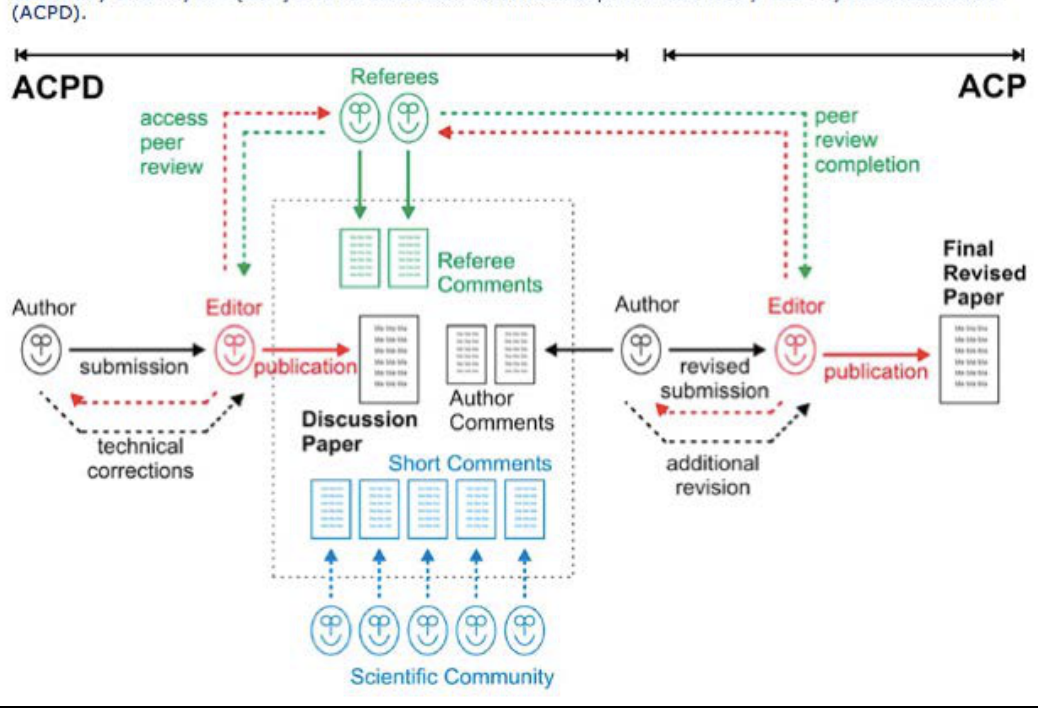
Figure 2 . Model of peer and public review of scholarly articles from Pösch